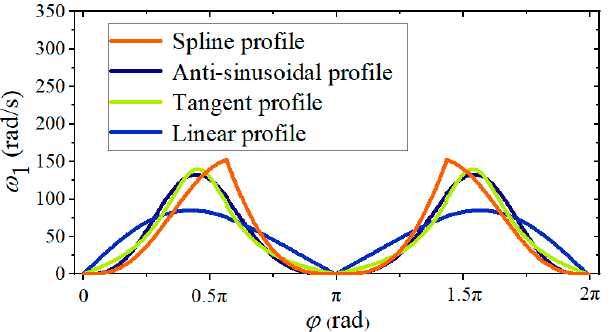
Figure 5. Angular velocity of the rotating sleeve.